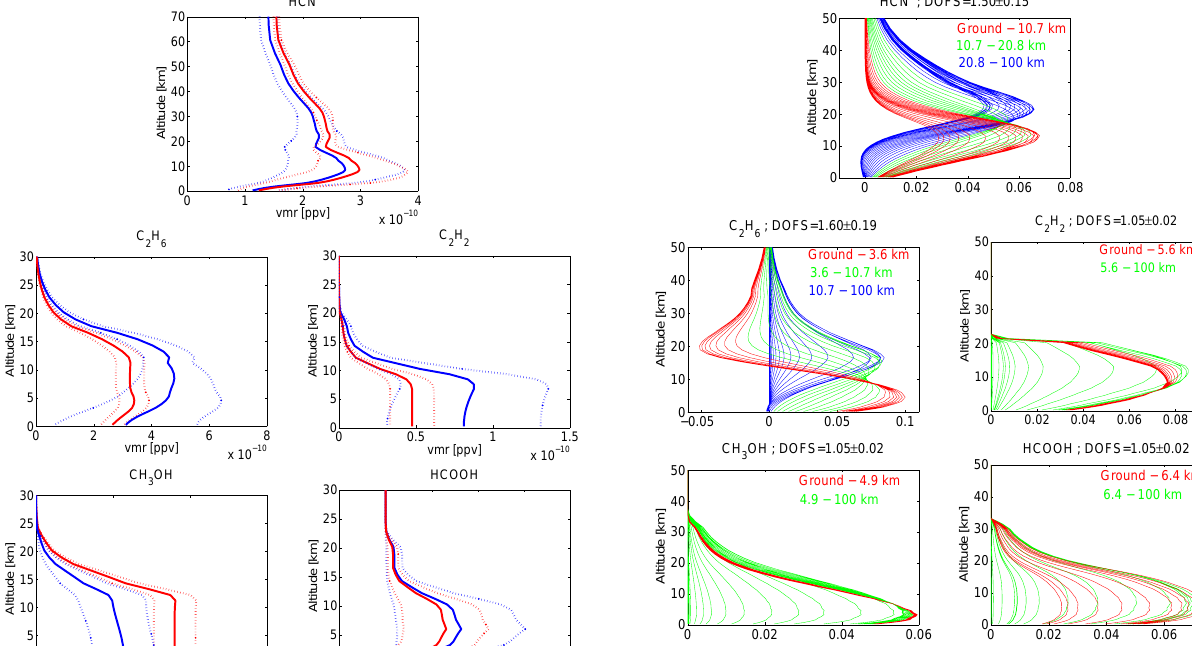
Fig. 2. FTIR volume mixing ratio averaging kernels (ppvppv − 1 ) of the five retrieved species. The total DOFS for each species is given in the titles. Each line corresponds to the averaging kernel at a given altitude, the retrievals being made with a 47 layers grid. We have used the same color for the averaging kernels at altitudes lying in a partial column for which we have about a DOFS of 0.5. The partial columns boundaries are given in the